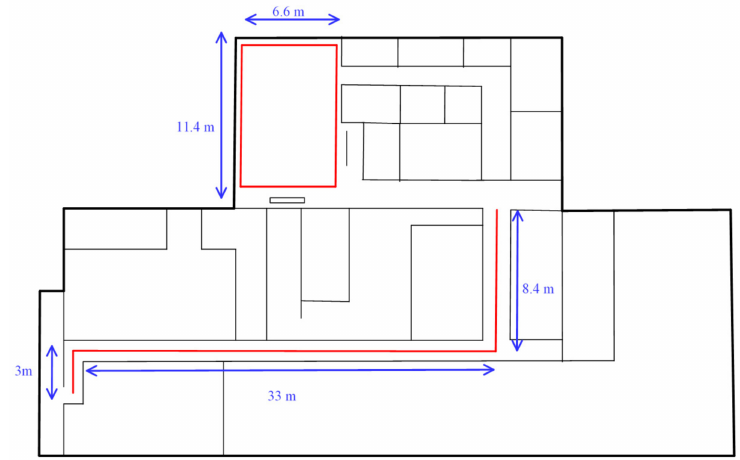
Figure 12. Floor plan of the first floor of the building.